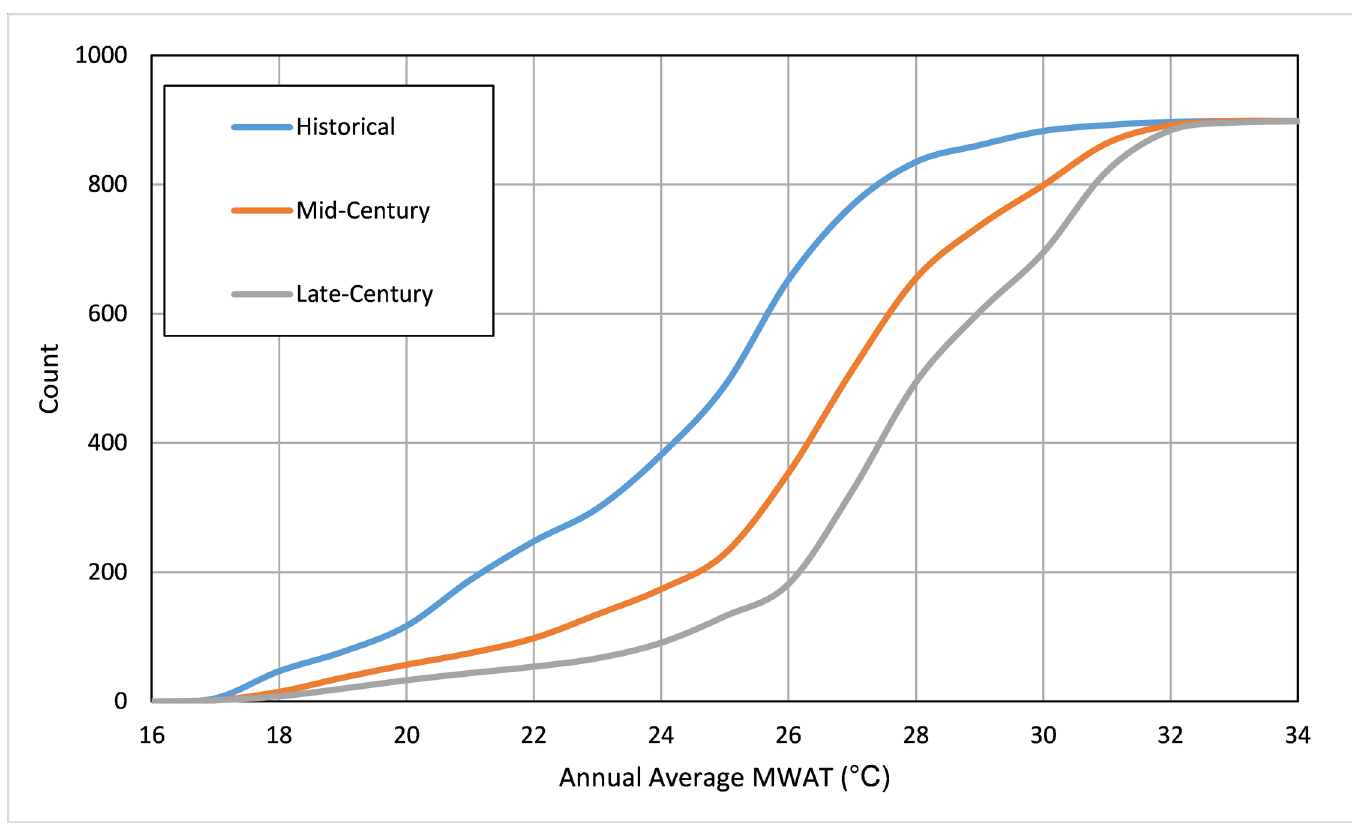
Fig 5. Cumulative frequency distribution of